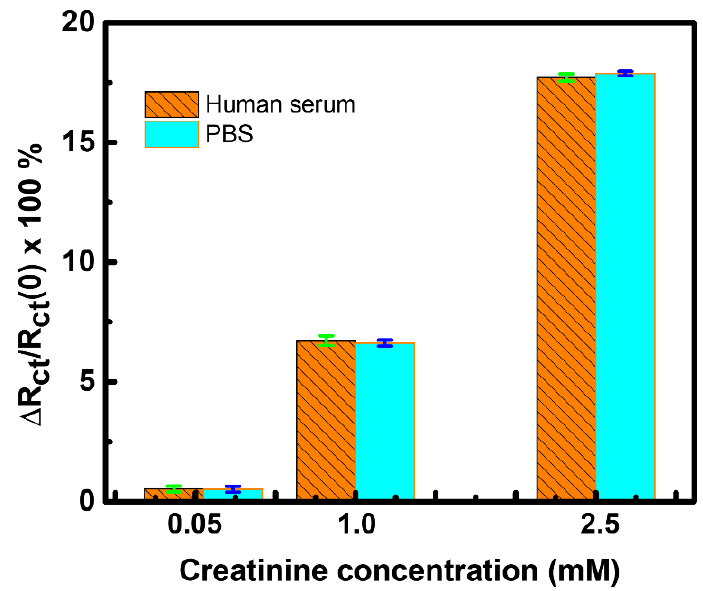
Figure 10. Comparison bar graph of creatinine detection by ZIF-8 NPs/PEDOT:PSS/ITO in PBS and human serum.